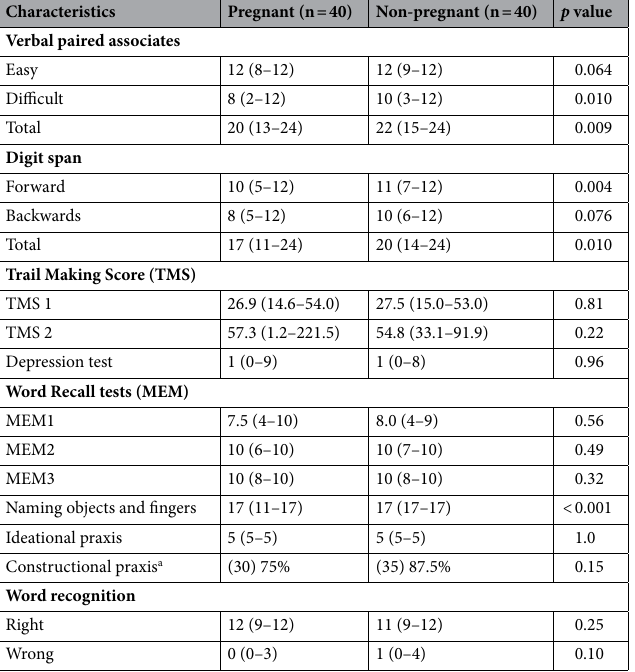
Table 2. Results of cognition and memory test according to the study groups. a Data are presented as median (range) n